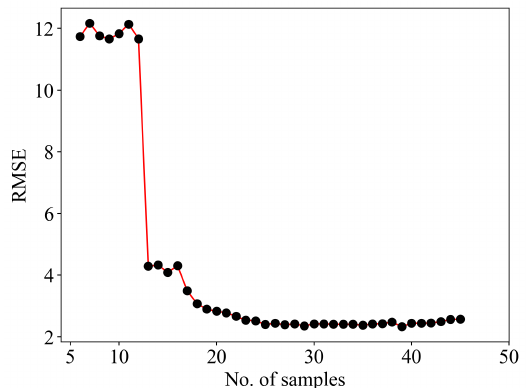
Figure 5. The RMSE convergence curve of the CV-Voronoi sampling process.